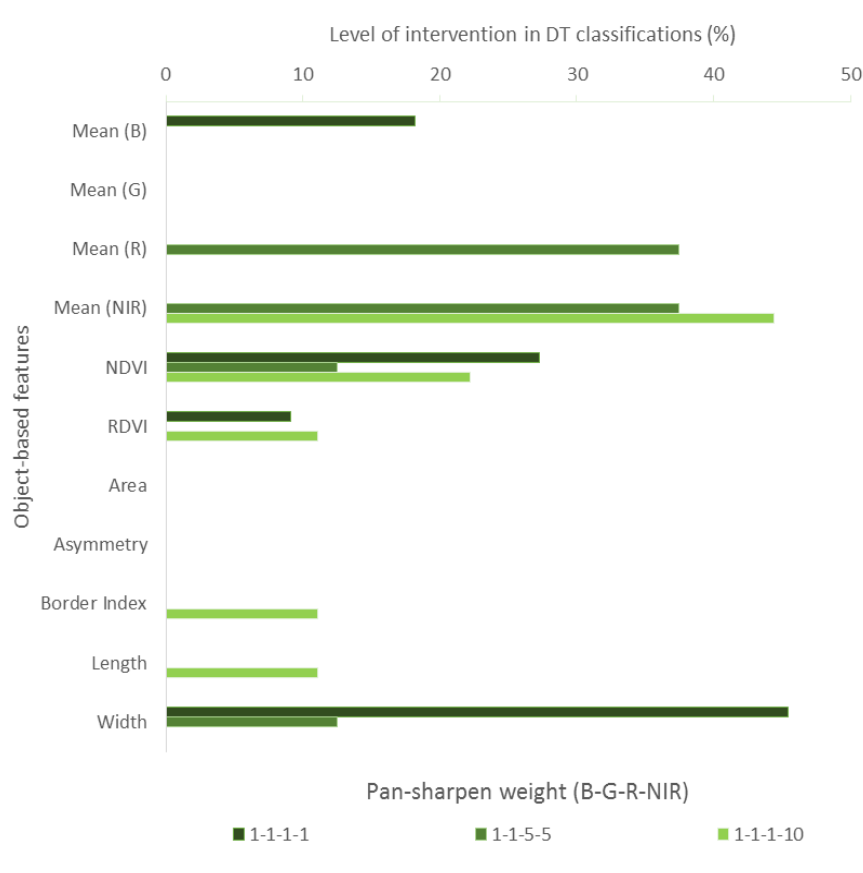
Figure 4. Relative contribution of object-based variables for DT classifications.